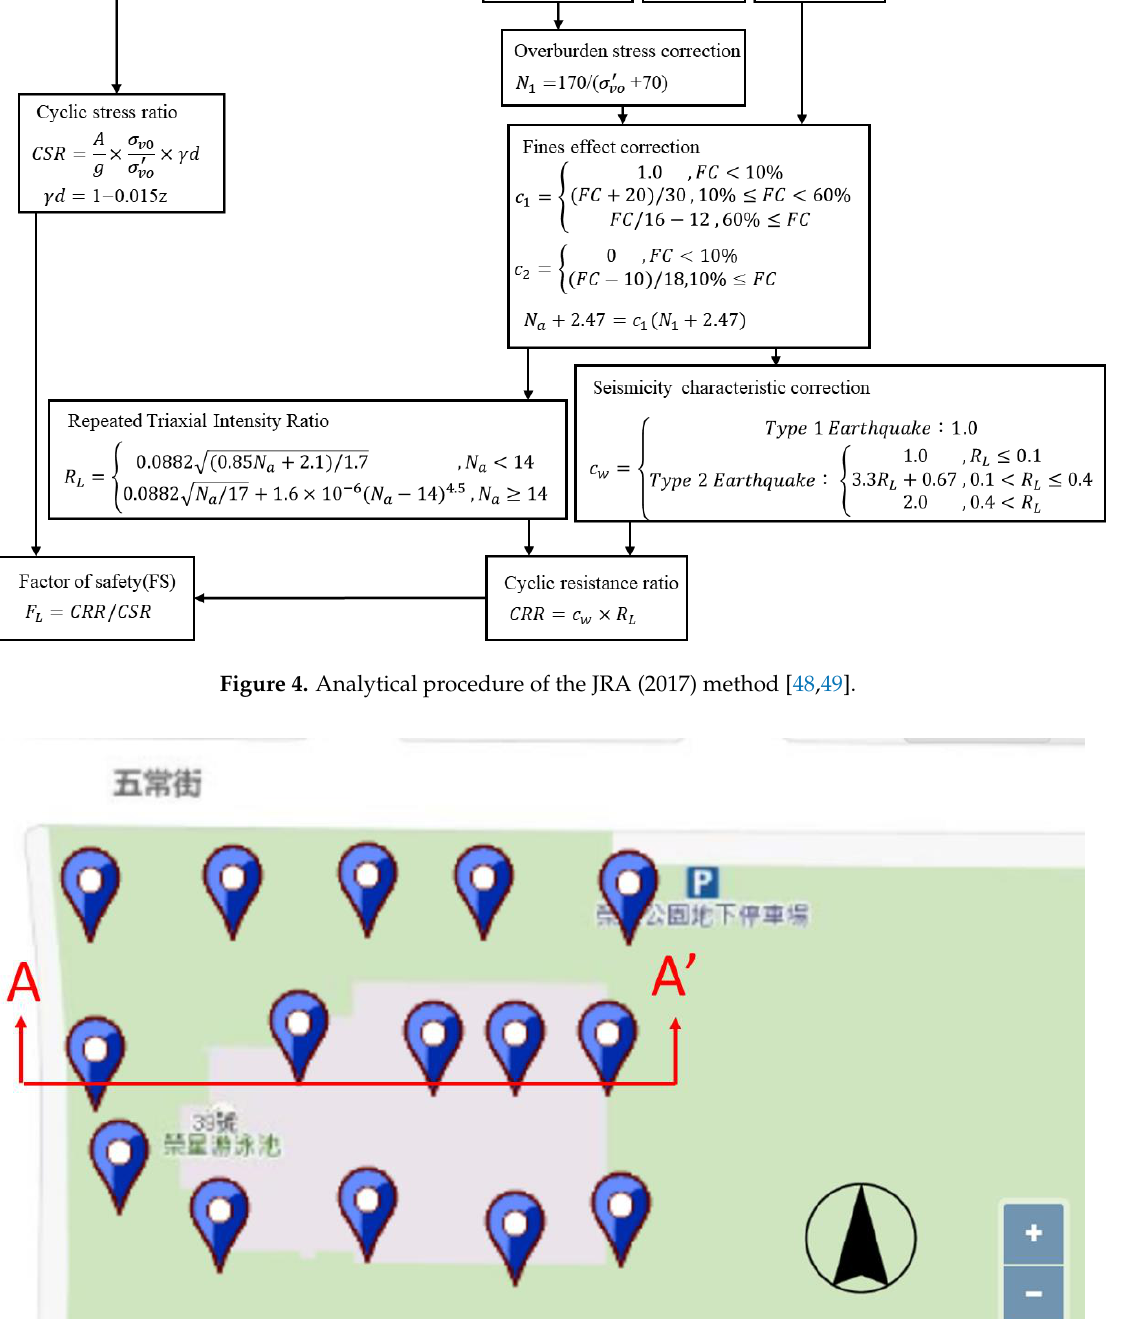
Table 1. The relevant parameters and coefficients of variance in the liquefaction-potential evalua- tion of a construction project in northern Taiwan.